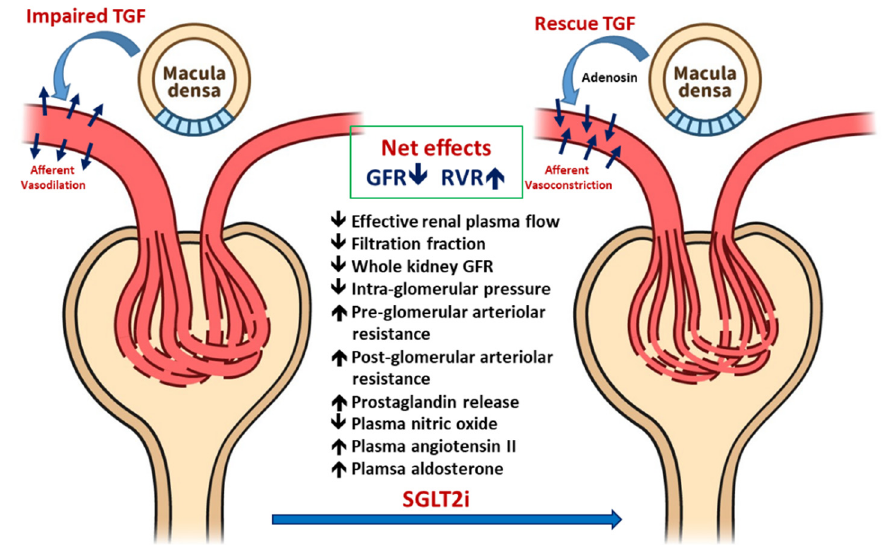
Figure 1. Hemodynamic responses to a sodium-glucose transporter 2 inhibitor (SGLT2i) in patients with early stage type 1 diabetes mellitus (T1DM): in the early stage of T1DM,